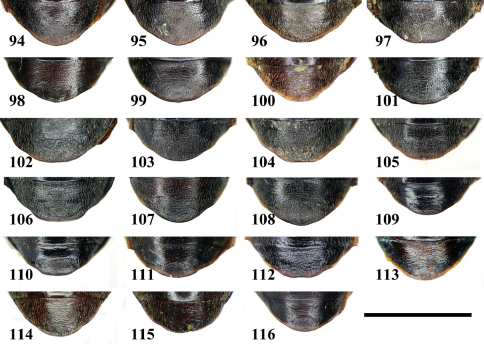
Abdominal sternum VII (ventral aspect) of Chlaenius (Lithochlaenius) species94 Chlaenius chuanqianensis sp. n., male, holotype95 Chlaenius chuanqianensis sp. n., female, paratype96 Chlaenius linwensini sp. n., male, holotype97 Chlaenius linwensini sp. n., female, paratype98 Chlaenius propeagilis sp. n., male, holotype99 Chlaenius propeagilis sp. n., female, paratype100 Chlaenius agilis Chaudoir, male, holotype101 Chlaenius formosensis Lorenz, male102 Chlaenius formosensis Lorenz, female103 Chlaenius leishanensis Kirschenhofer, male104 Chlaenius leishanensis Kirschenhofer, female105 Chlaenius noguchii Bates, male106 Chlaenius noguchii Bates, female107 Chlaenius wrasei Kirschenhofer, male108 Chlaenius wrasei Kirschenhofer, female109 Chlaenius agiloides Jedlička, male110 Chlaenius agiloides Jedlička, female111 Chlaenius rambouseki Lutshnik, from Ussuri region, male112 Chlaenius rambouseki Lutshnik from Ussuri region, female113 Chlaenius anchomenoides Bates, male, paratype114 Chlaenius nuristanus Jedlička, male, paratype115 Chlaenius nuristanus Jedlička, female, paratype116 Chlaenius formosanus Jedlička from Taiwan, male. Scale line = 1.0 mm.